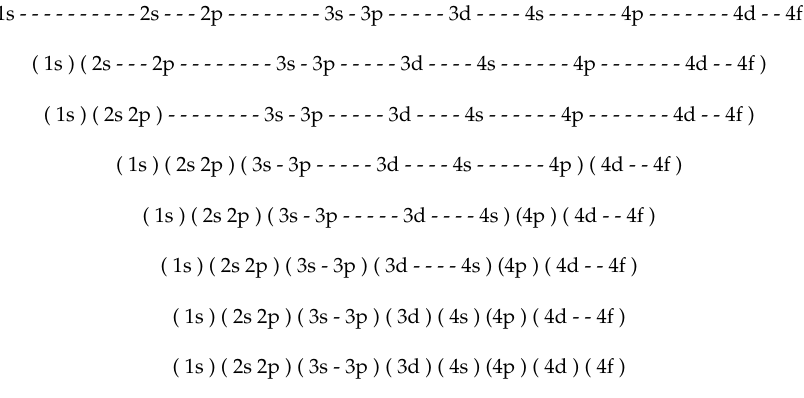
Figure 3. Illustration of the method described in Section 7.1.